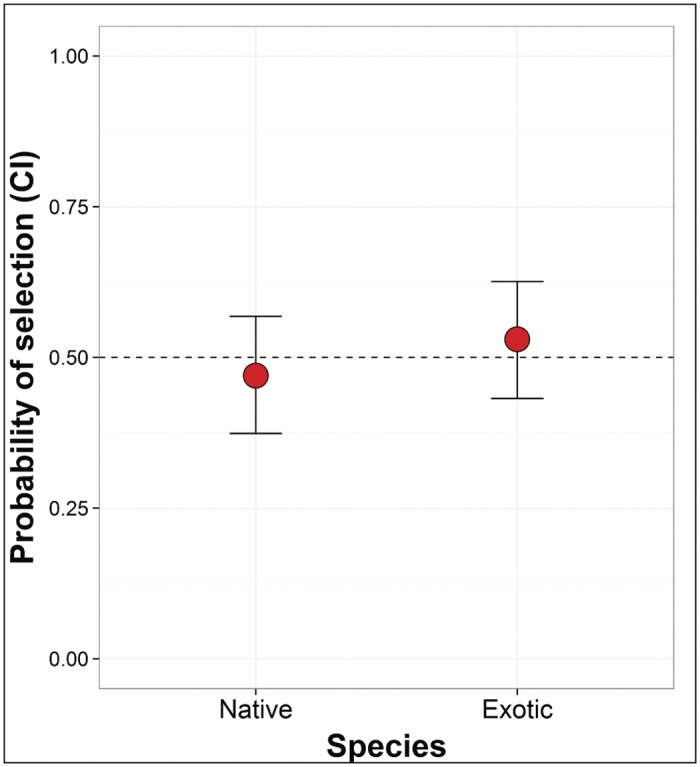
Probability of snail kite selecting a native or exotic snail.Model predicted foraging preference (with 95% confidence intervals) of snail kites foraging on native or exotic snails using only the first choice made during experimental trials.